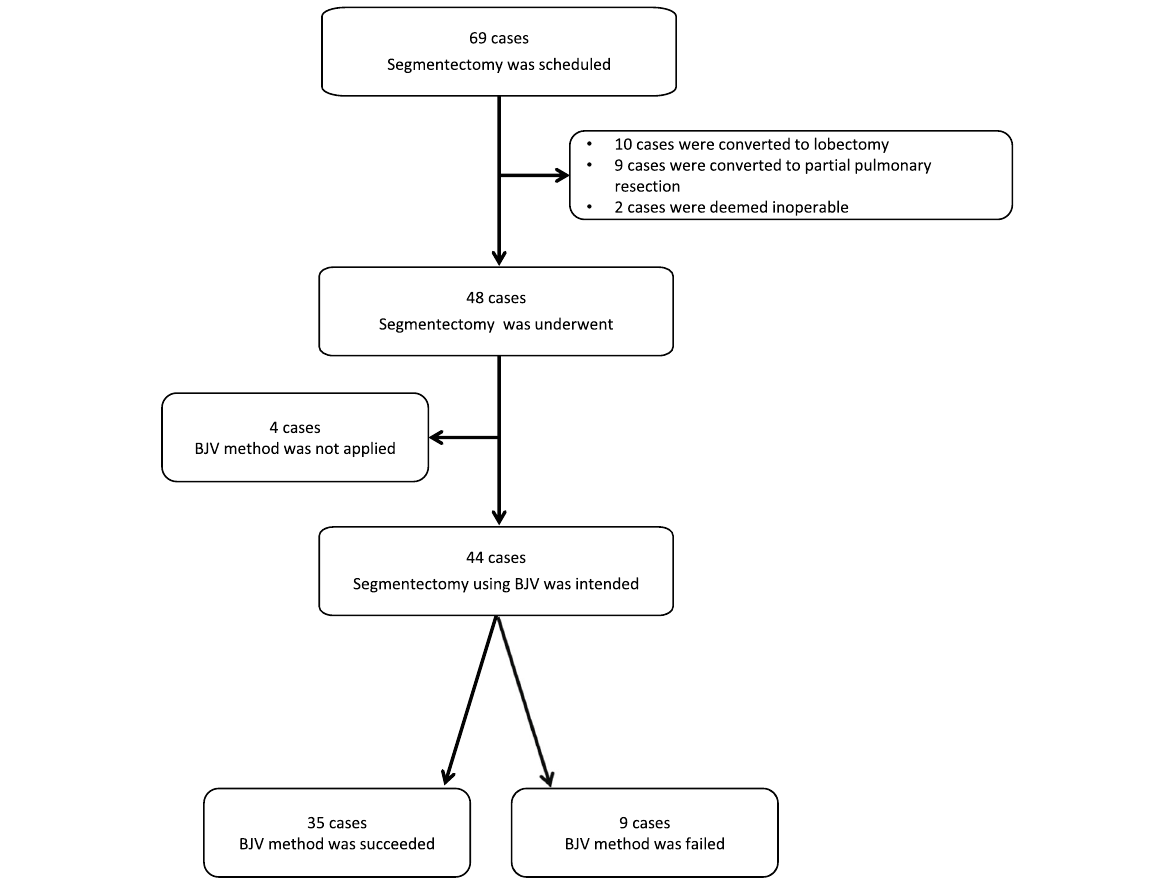
Fig. 1 Flow chart showing patients scheduled for pulmonary